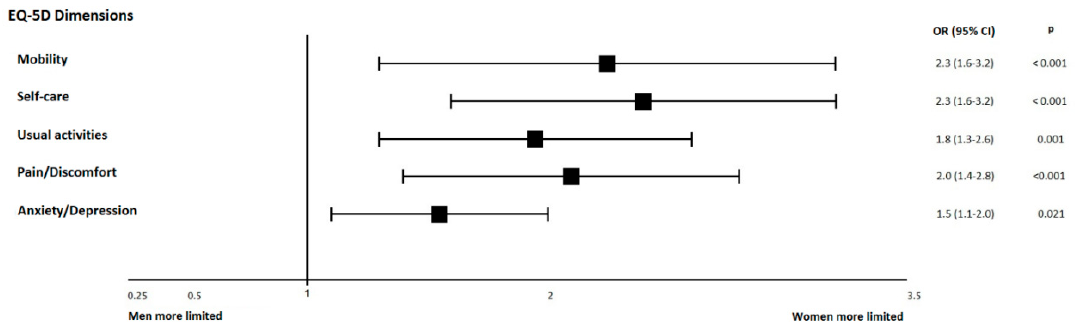
Figure 3. Multivariate binary logistic regression evaluating the association of gender with the probability of reporting limitations in the 5 dimensions captured in the EQ-5D (mobility, usual activities, self-care, pain / discomfort, or anxiety / depression). Results are representing odds ratios and 95% confidence intervals comparing women with men (reference category) of reporting any limitation in each of the dimensions of the EQ-5D questionnaire. Variables included in multivariate model were those factors that showed significant association with health-related quality of life (HRQoL) in univariate analyses.